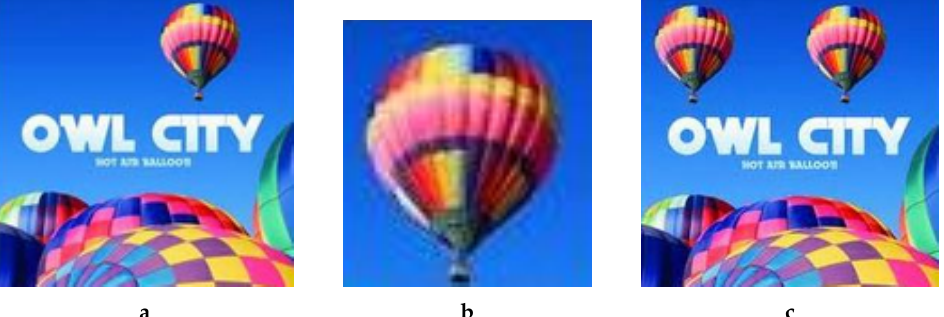
Figure 3. A simulation example of copy/move forgery. ( a ) Original/Host Image, ( b ) Patch Image, ( c ) Forged Image.